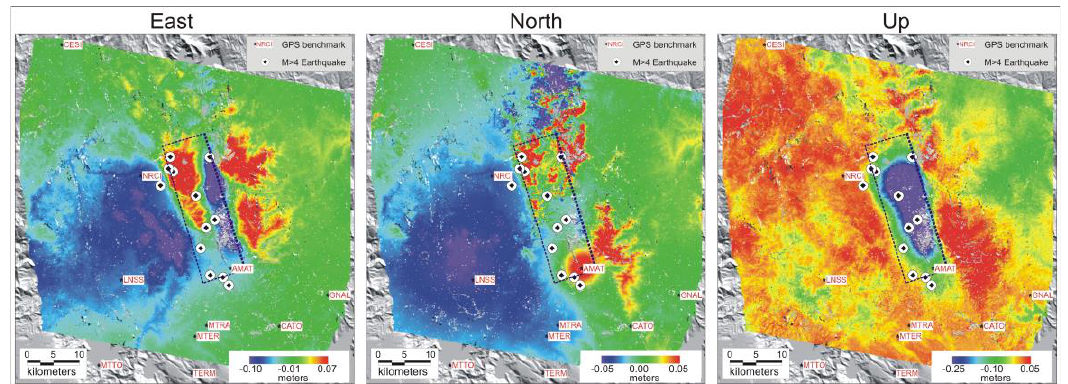
Figure 2 . SISTEM results: East, North, and Up components of the displacement field are reported, respectively. The dashed box refers to the inverted fault plain.